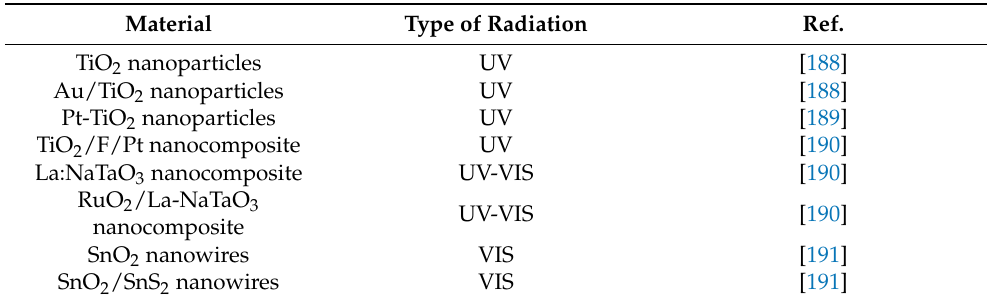
Table 3. Examples of photocatalysts that can be used in the decomposition of water under the influence of UV radiation in the ultraviolet range and VIS radiation in the visible range.